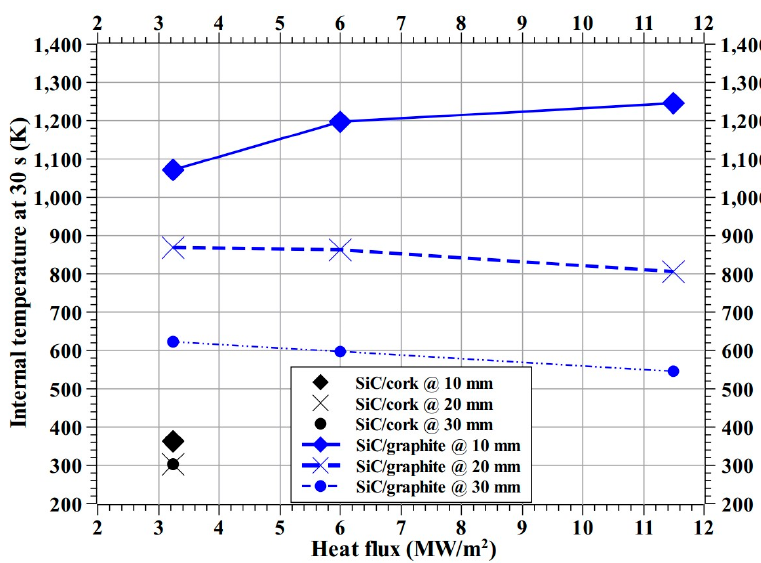
Figure 26. Internal temperature at 30 s (SiC/cork and